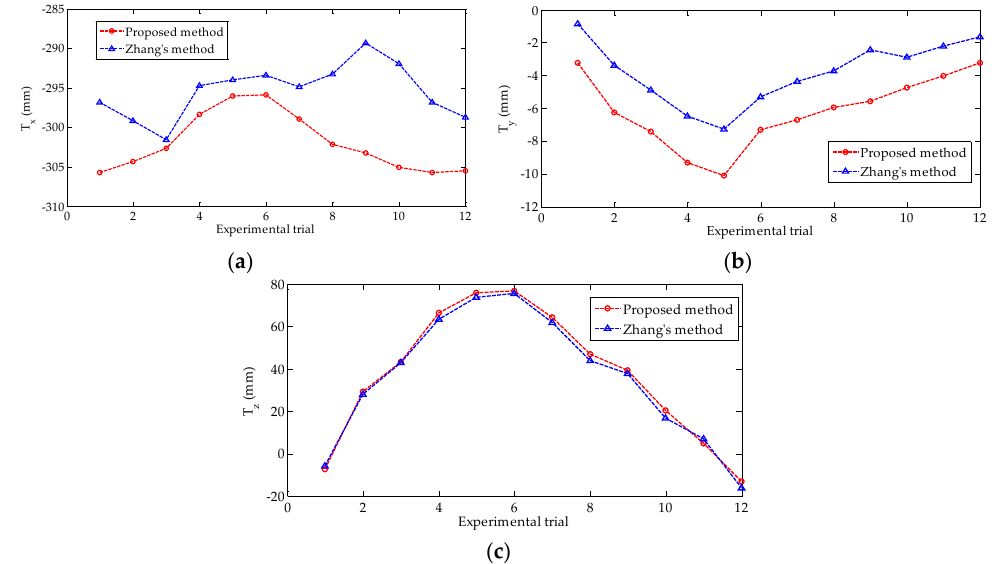
Figure 11. Translation vector estimated by using the proposed and Zhang’s methods: ( a ) T x of the two methods; ( b ) T y of the two methods; ( c ) T z of the two methods. Sensors 2018 , 18 , x FOR PEER REVIEW